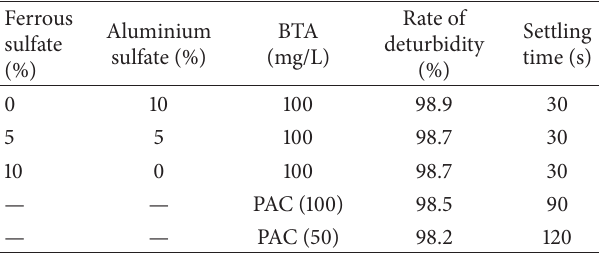
Table 5: The influence of additives on coagulation behaviors of BTA with 30% PAC (200NTU diatomite suspension).